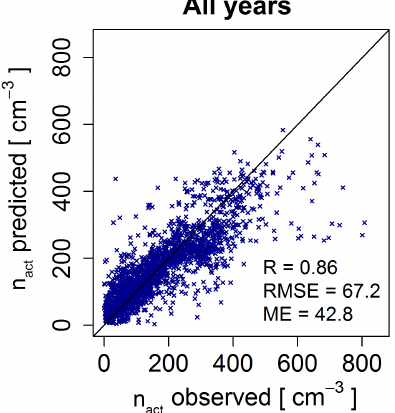
Figure 7. The number of cloud droplets calculated with the micro- physical parametrization, plotted against the measured number of residuals.